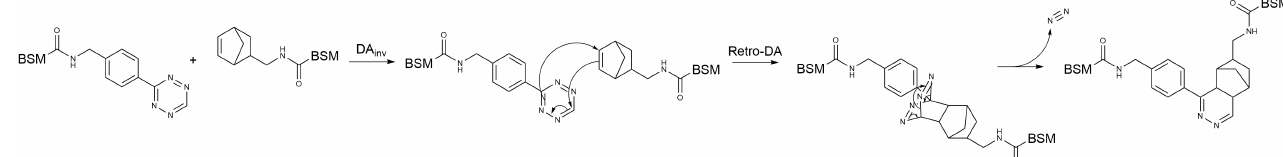
Figure A4. Reaction mechanism Inverse electron demand